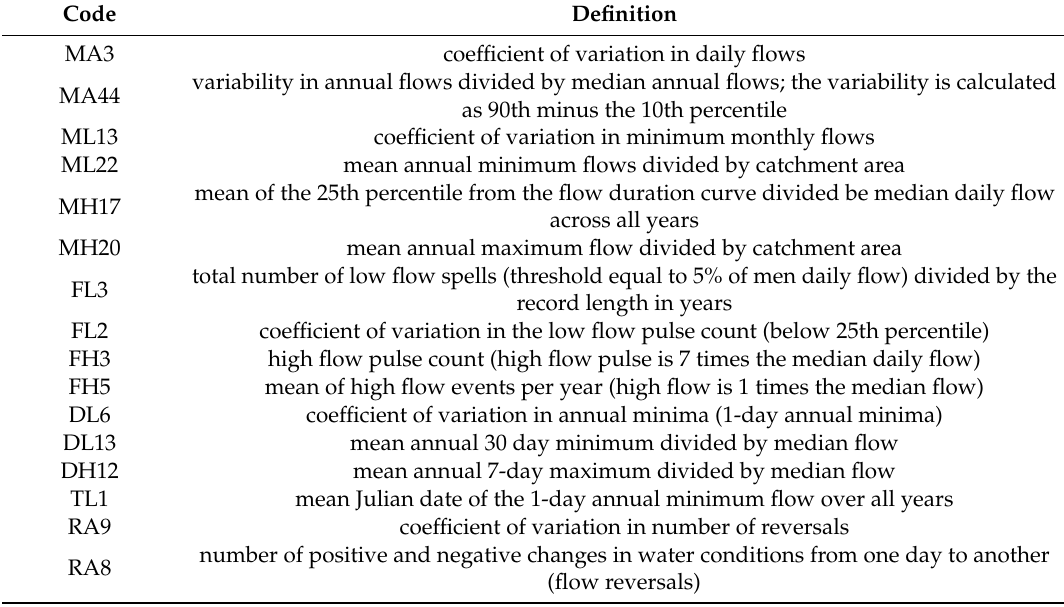
Table 3. Selected indicators of flow regime changes proposed for the evaluation of perennial streams with snow and rain regime by